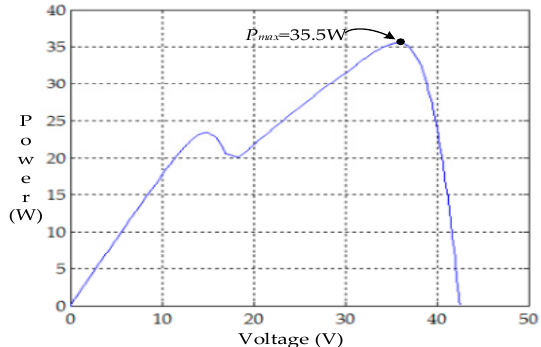
Figure 9. Simulation of P–V characteristic curve in Case 2.